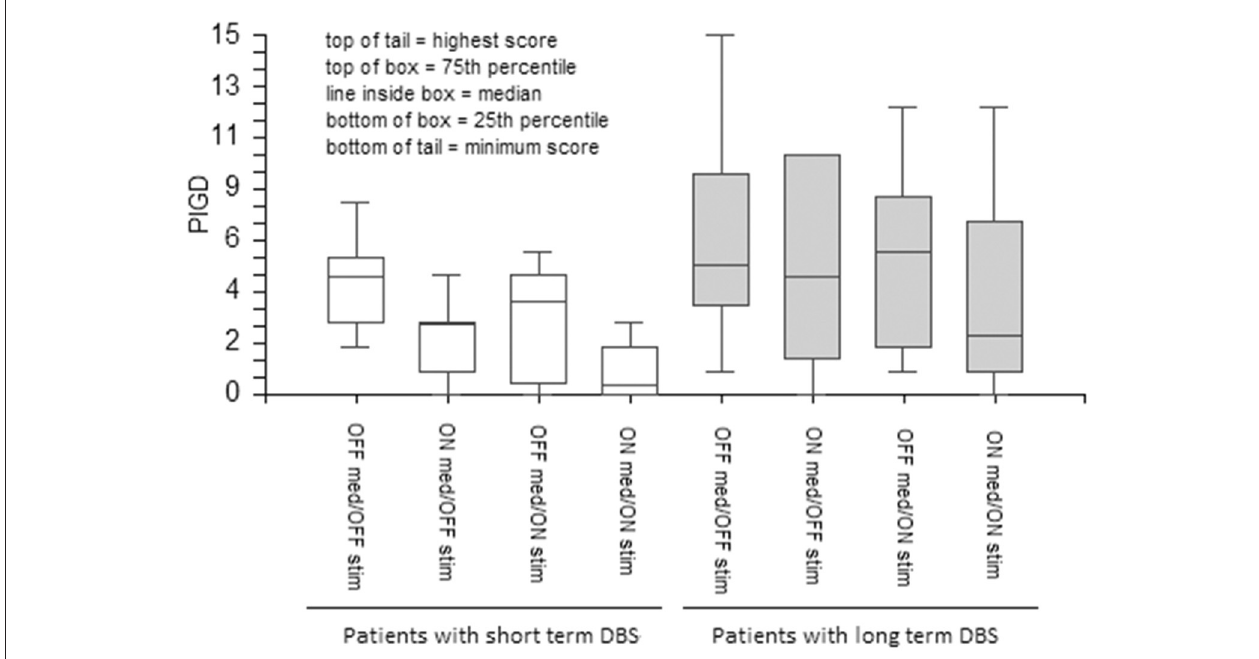
FIGURE 2 | The effect of medication and stimulation on PIGD (items 27–30 of UPDRS) in patients with short- and long-term DBS. PIGD, Postural instability and gait disorders; PD, Parkinson’s disease; UPDRS, The Unified Parkinson’s Disease Rating Scale; DBS, Deep Brain Stimulation; GABS, Gait and Balance